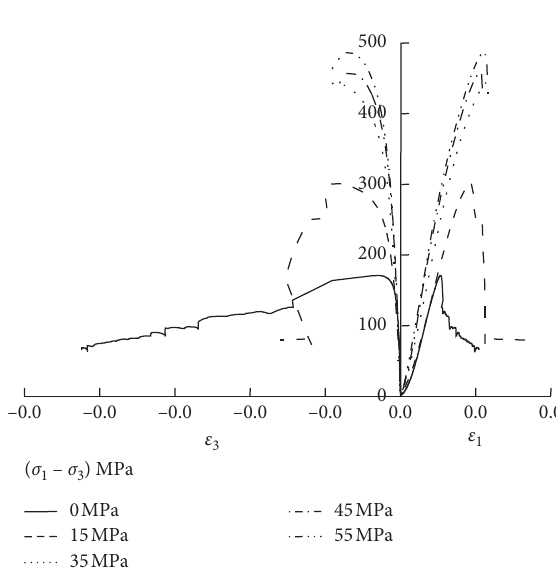
Figure 2: Stress-strain curves for conventional triaxial tests.